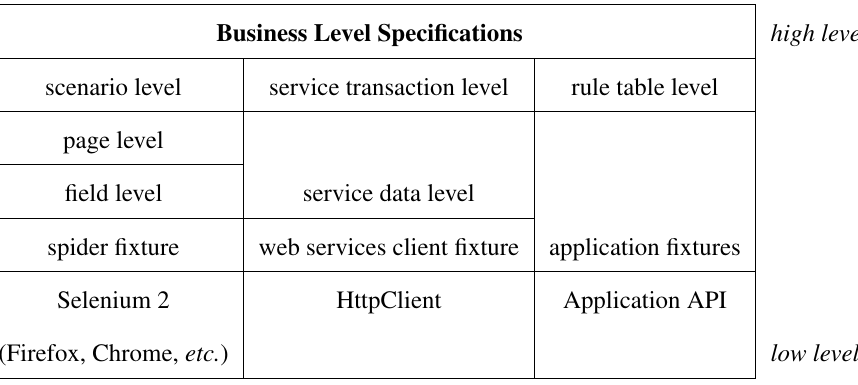
Table 1. Multiple levels mapping to multiple